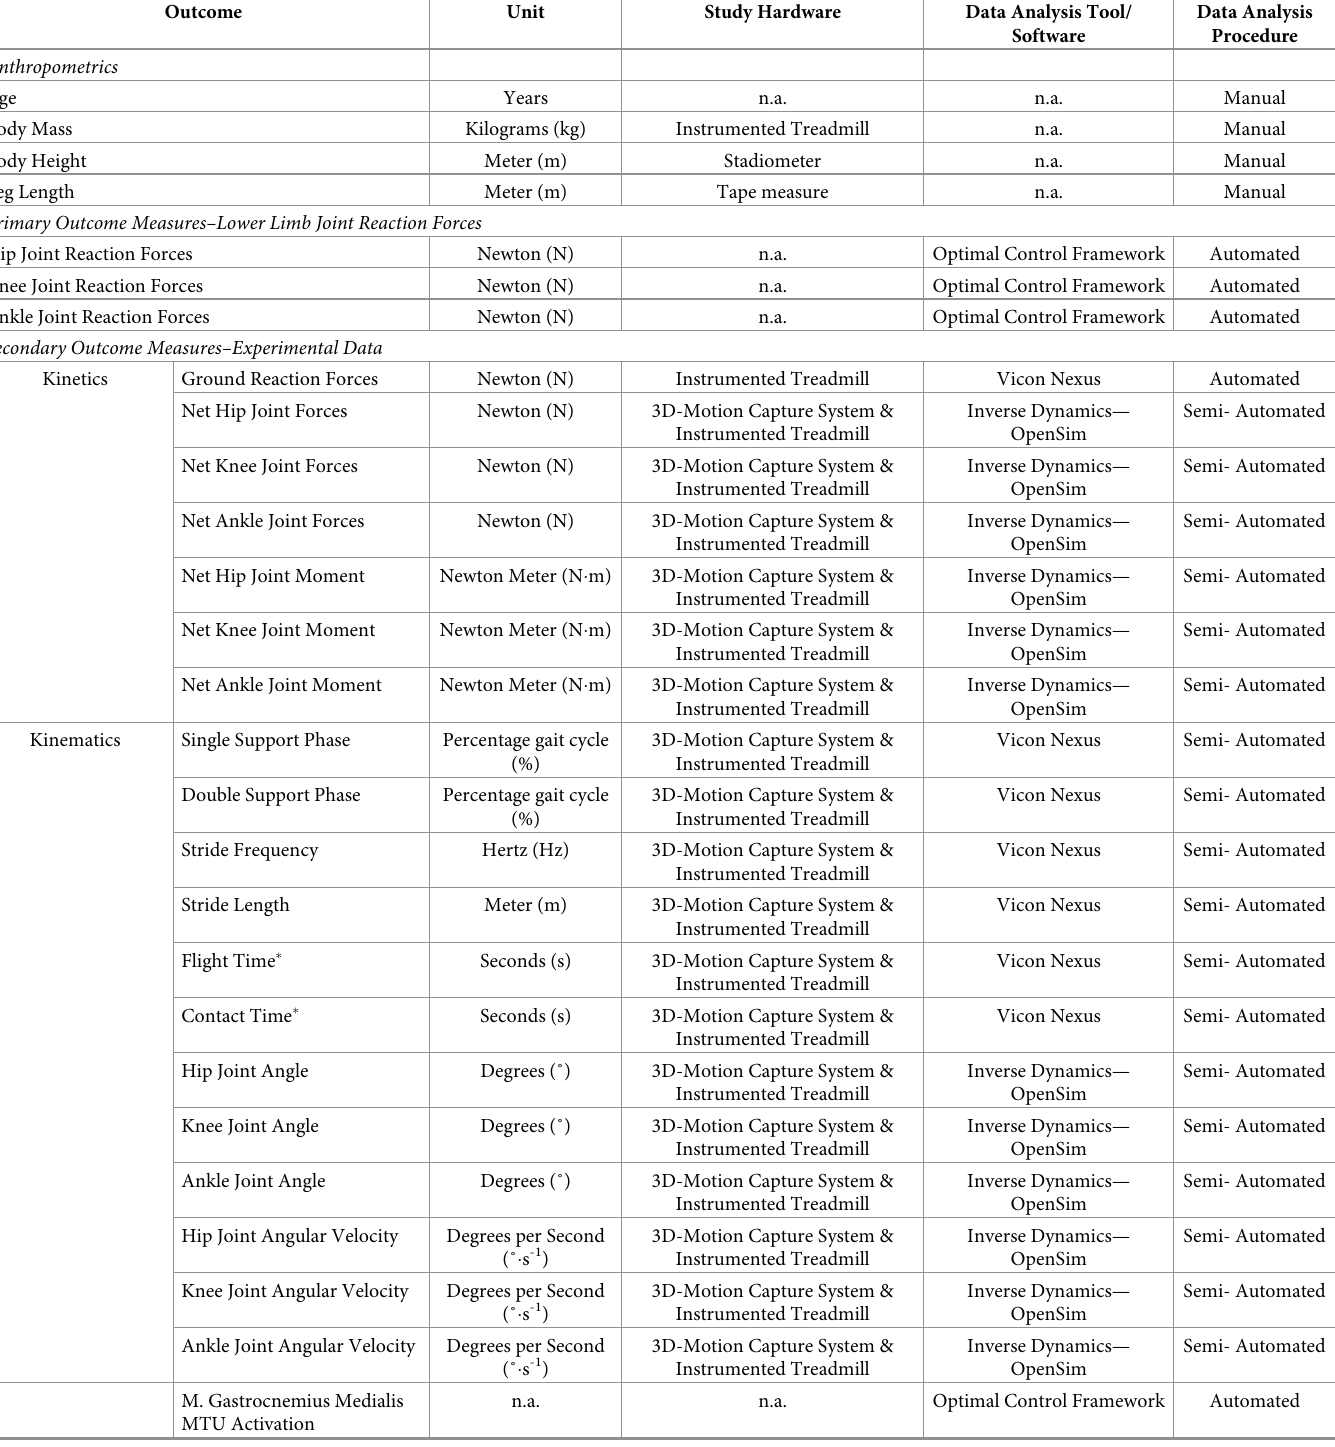
Table 4. Overview of the anthropometrics, primary and secondary outcome measures to be